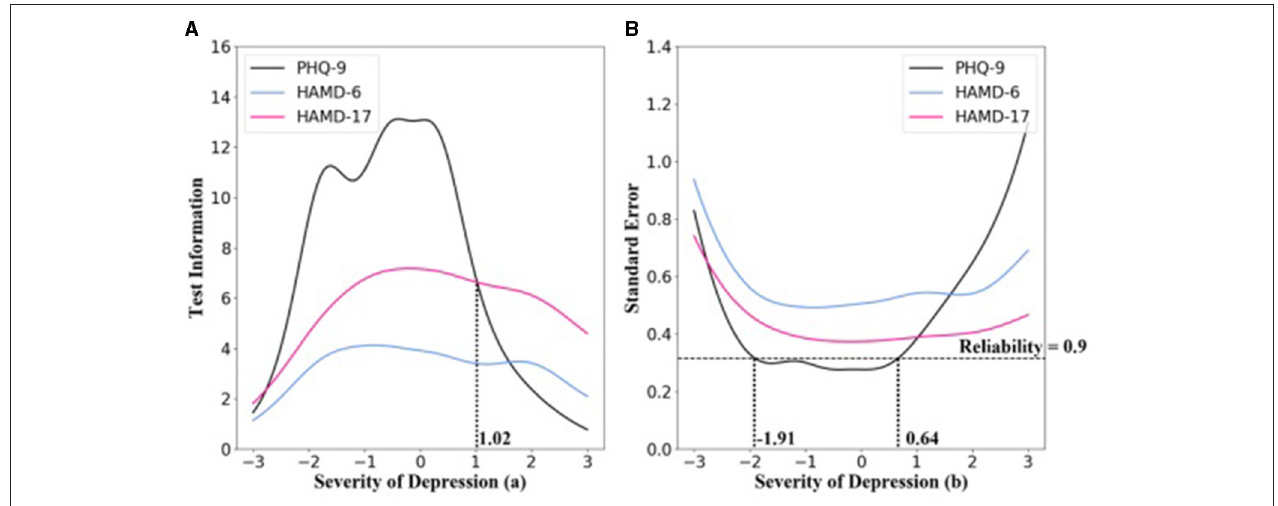
FIGURE 2 | Test information functions (TIFs) curves of PHQ-9, HAMD-6, and HAMD-17. (A) Test information function for PHQ-9, HAMD-6, and HAMD-17. (B) Standard error for PHQ-9, HAMD-6, and HAMD-17. Below the dotted line indicates that the reliability was > 0.9.